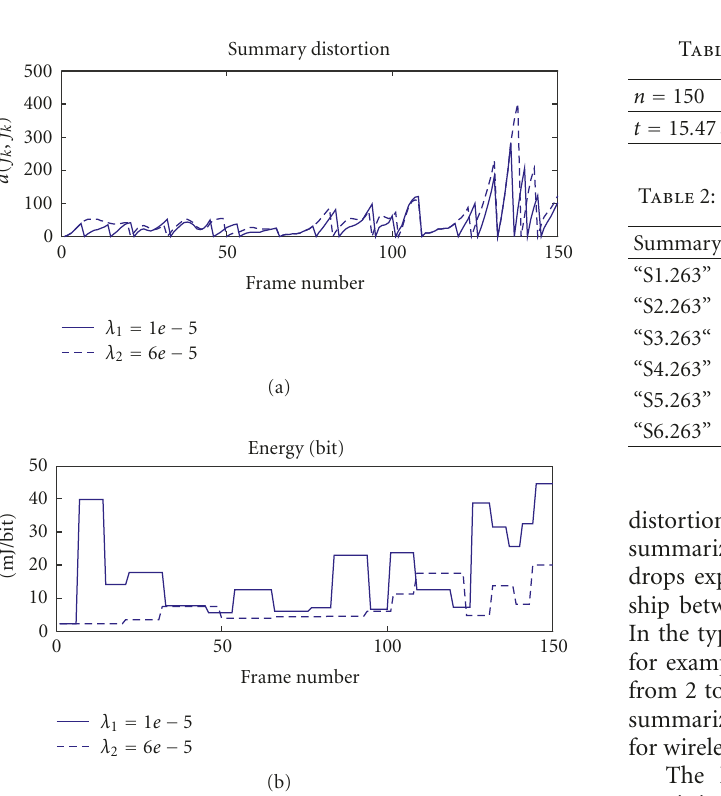
Figure 5: Examples of energy-e ffi cient video summarization for the average distortion case.